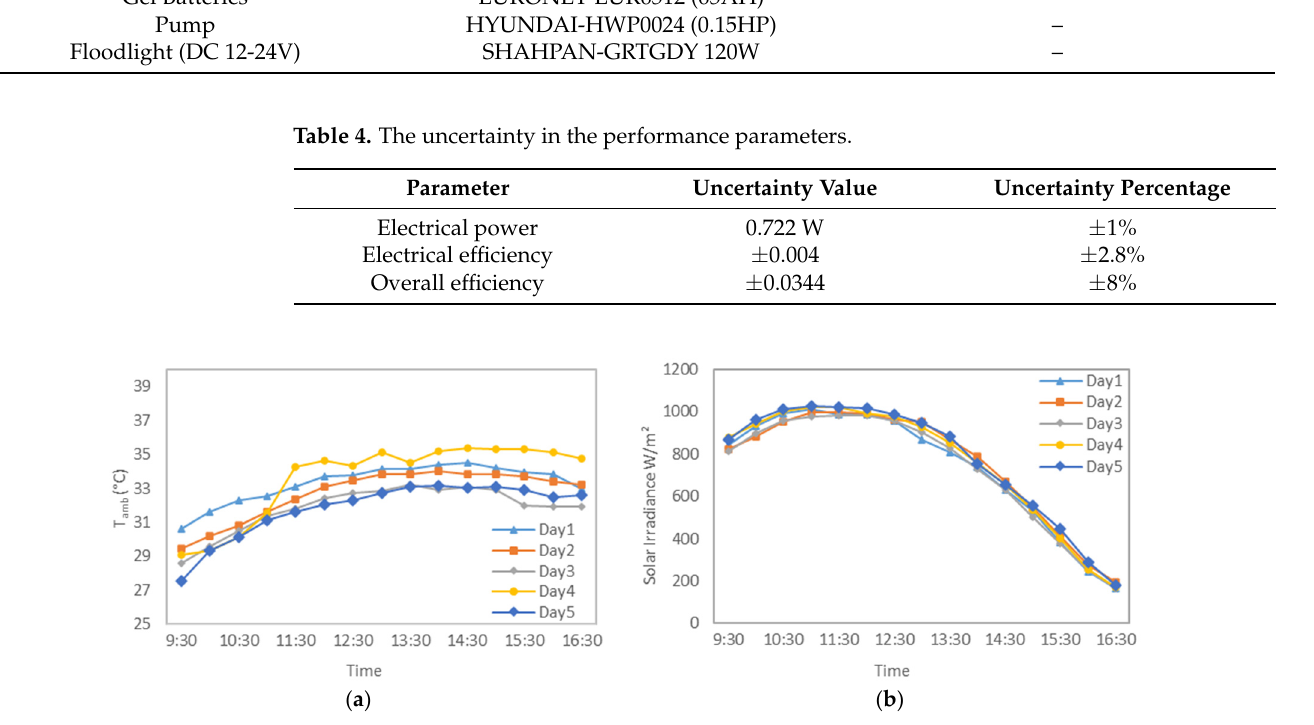
Figure 5. The weather conditions during five days in October 2022 in Riyadh from 9:30 to 16:30: ( a ) ambient temperature, and ( b ) total solar irradiance.